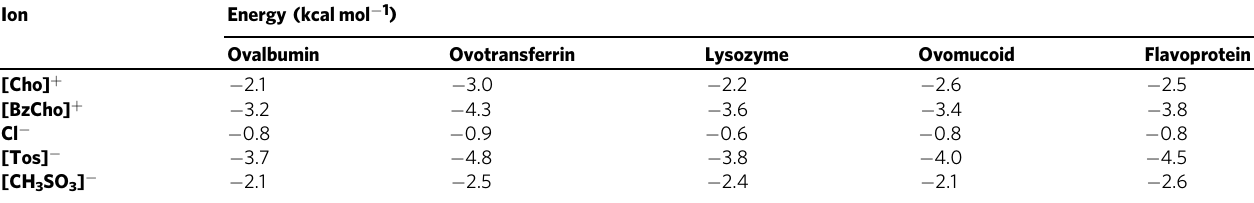
Table 1 Interaction energies of the IL ions with the proteins present in egg